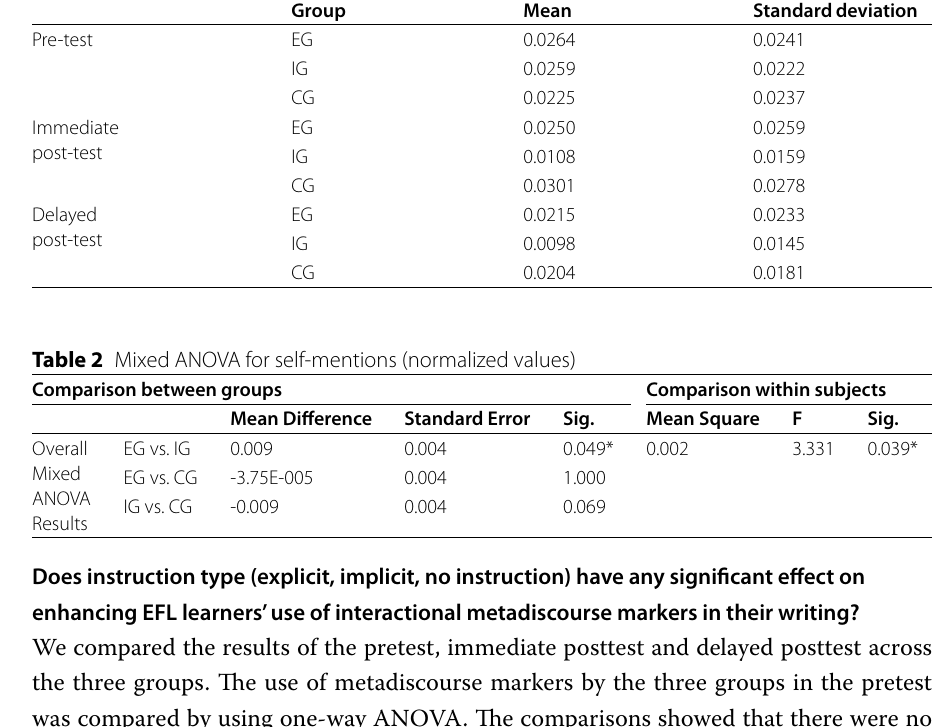
Table 1 Descriptive statistics for self-mentions (normalized values) Group